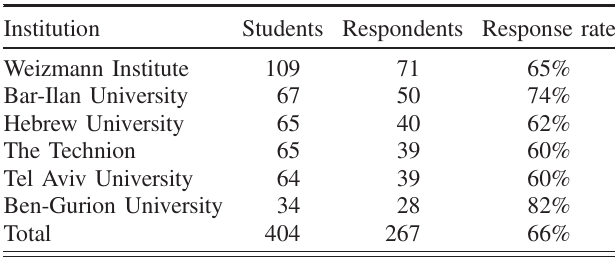
TABLE I. Physics Ph.D. students in Israel: the overall pop- ulation and the number of respondents by